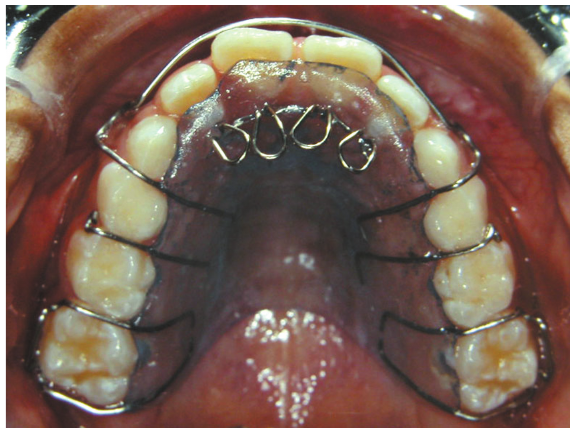
Figure 1- Removable palatal